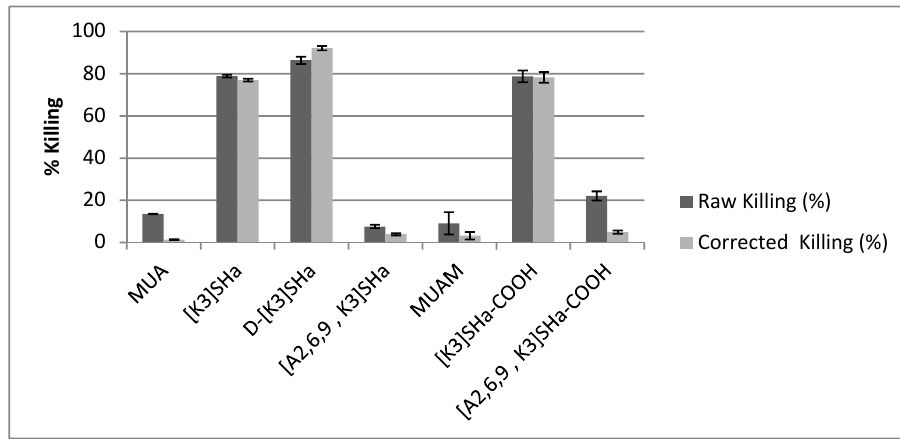
Figure 5. Killing efficiency towards L. ivanovii bacteria compared to gold bare substrate for MUA and MUAM, to MUA for [K 3 ]SHa, D -[K 3 ]SHa, [A 2,6,9 , K 3 ]SHa, and to MUAM for [K 3 ]SHa-COOH and [A 2,6,9 , K 3 ]SHa-COOH, respectively. The raw data (dark bars) are compared to the data corrected by the adhesion factor (light bars). The killing of X compared to its control is calculated using %Killing X = [(CFU CONTROL − CFU X )/CFU CONTROL )] × 100. Error bars indicate standard deviation from three independent CFU